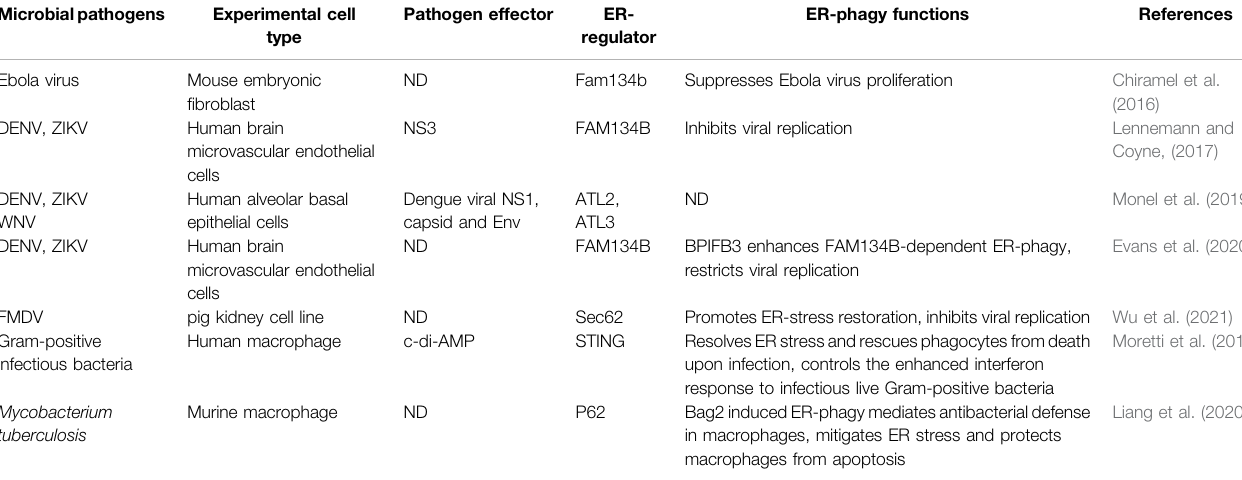
TABLE 1 | The regulatory role of ER-phagy in